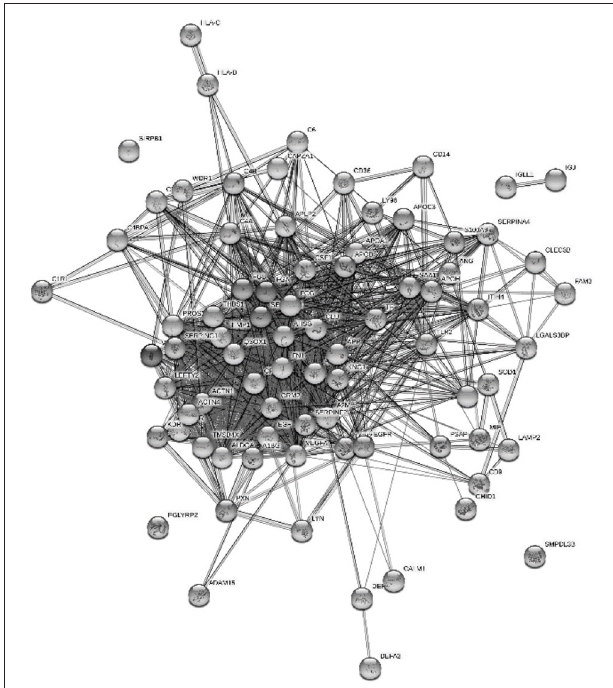
FIGURE 6 | Interaction of platelet degranulation and innate immune response protein in Chinese HM were enriched with DAVID Bioinformatics and visualized using STRING